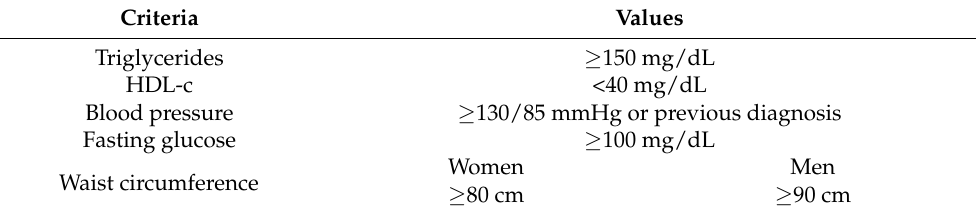
HDL-c: high-density cholesterol. Adapted from: